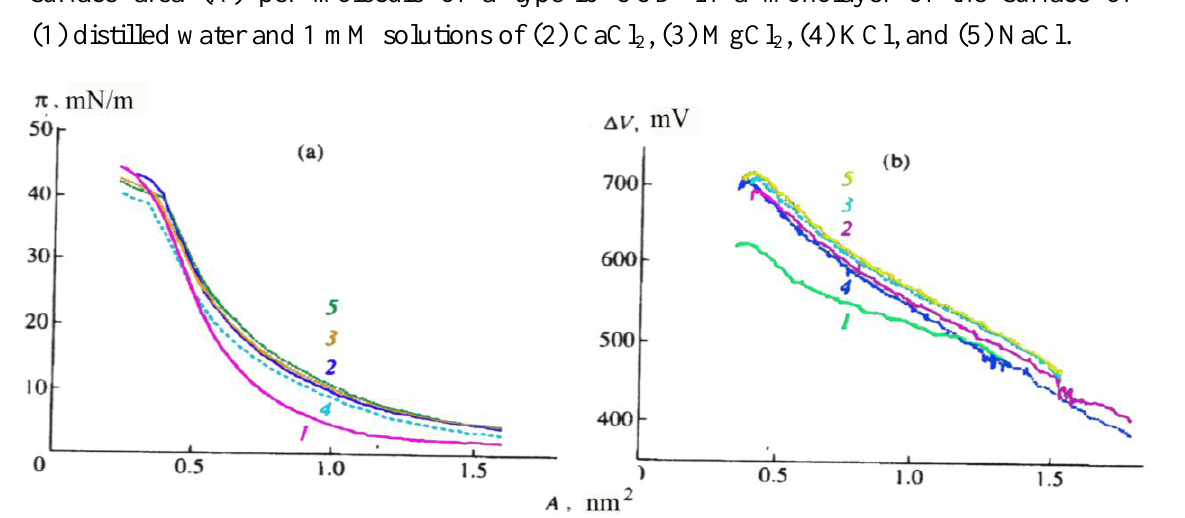
Figure 2. ( a ) Surface pressure (π), and ( b ) surface potential (∆V), as a function of the surface area (A) per molecule of a type-Ib CCD in a monolayer of the surface